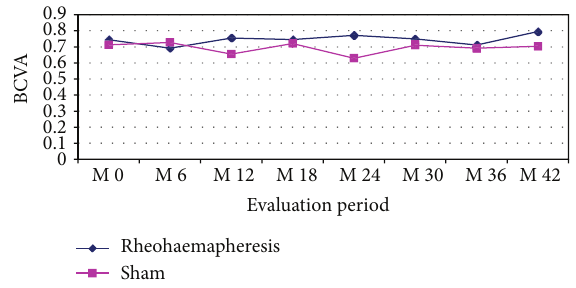
Figure 1: Development of BCVA during the follow up period in patients treated with rheohaemapheresis versus the control group.